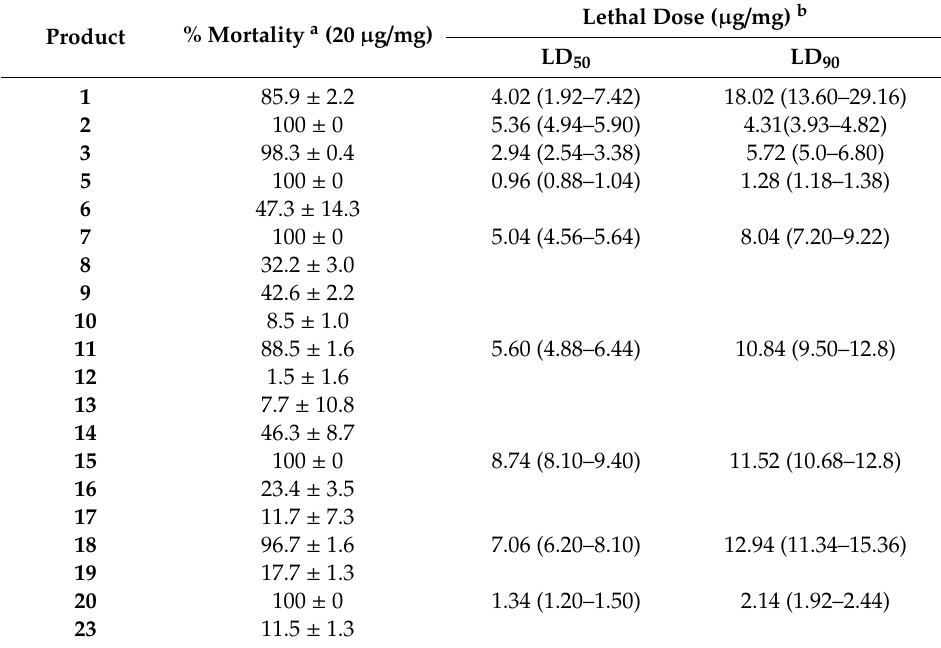
Table 3. Acaricidal activity of nootkatone ( 1 ) and derivatives 2 – 23 against H. lusitanicum